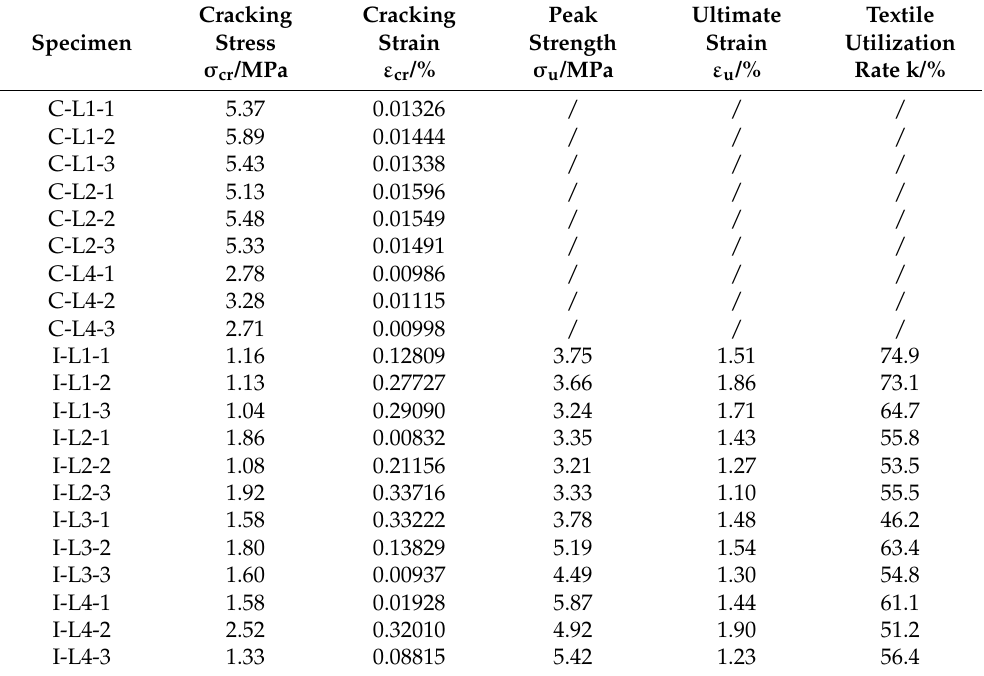
Table 3. Experimental